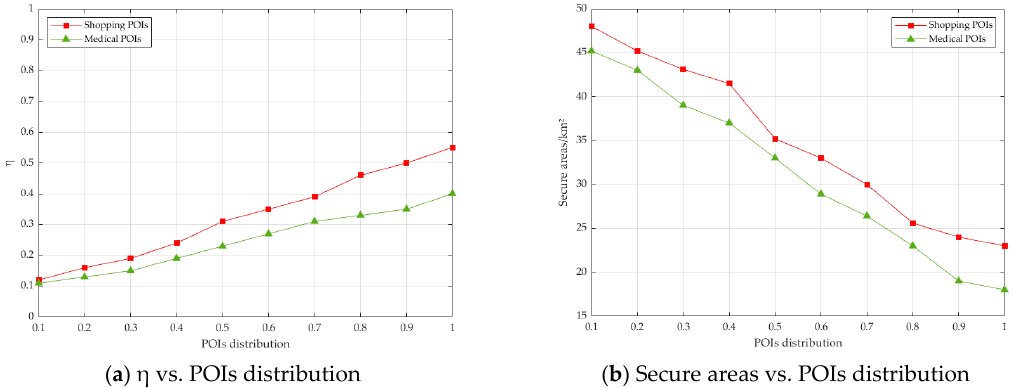
Figure 13. The effect of points of interest (POIs) distribution on η and Secure areas. Figure 13. The e ff ect of points of interest (POIs) distribution on η and Secure areas.